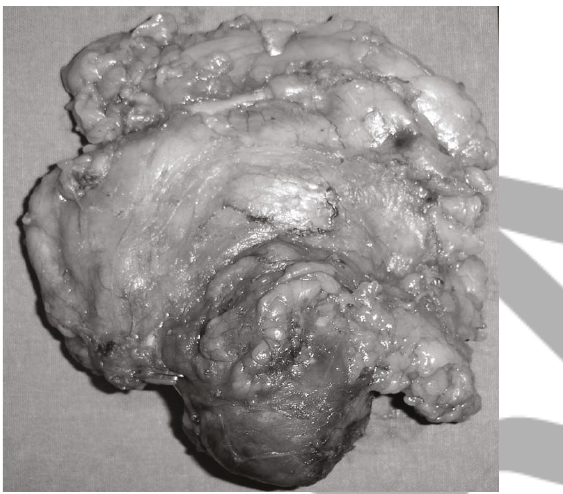
Figure 2: Photograph showing the gross appearance of the resected encapsulated